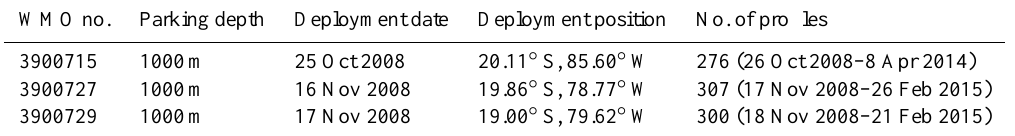
Table 1. VOCALS floats with oxygen sensors used here. The autonomous profiling explorer (APEX) floats had cycle intervals of 3 days for the first 11 months, and then the cycling interval was increased to 10 days. The APEX floats stayed at the surface for about 13h while the PROVOR float stayed at the surface for about 7h. According to the parking depths the floats are named here f330, f350, and f400. The deployment positions are shown in Fig. 1.